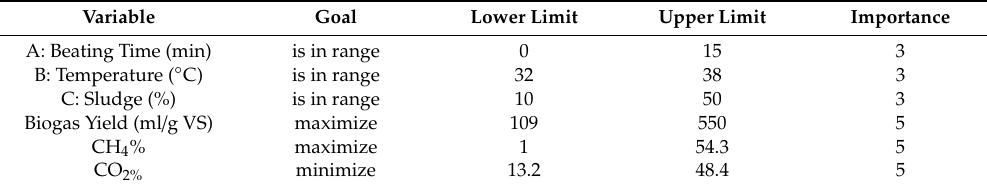
Table 19. Optimisation conditions for AD pot ale.